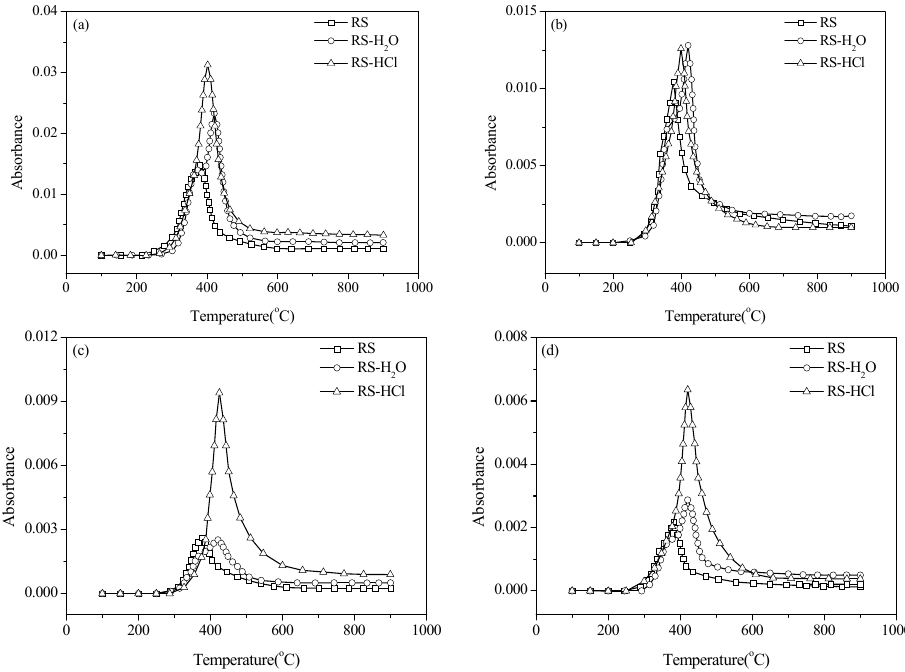
Figure 4. Release of N ‐ compounds for RS, RS ‐ H 2 O, and RS ‐ HCl. ( a ) ammonia (NH 3 ); ( b ) hydrogen